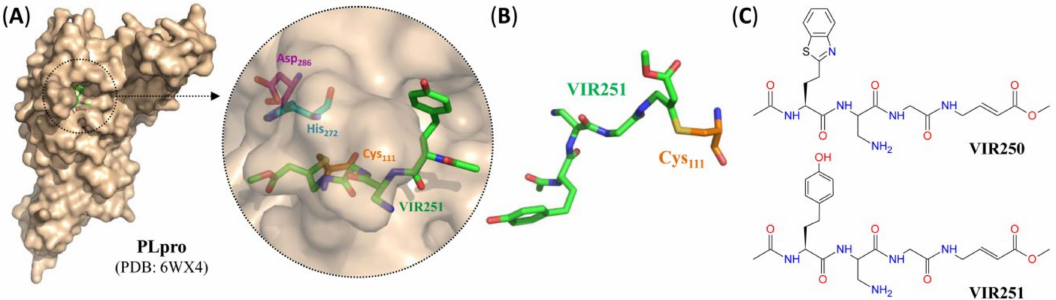
Figure 9. SARS-CoV-2 PLpro peptidomimetic inhibitors with an electrophilic vinyl methyl ester warhead. ( A ) Surface representation of the crystal structure of PLpro from SARS-CoV-2 with VIR251 (green) bound to the active site. Inset: close-up view of the inhibitor-bound active site, with residues forming the catalytic triad indicated in turquoise (His 272 ), orange (Cys 111 ) or purple (Asp 286 ) and hydrogen bonds indicated by dashed black lines. ( B ) Stick representation of VIR251 (green) covalently bound to the catalytic cysteine residue (orange). ( C ) Structure of di ff erent peptidomimetic SARS-CoV-2